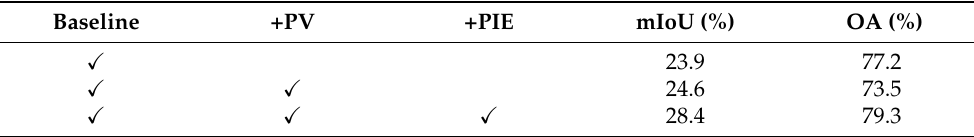
Table 4. The ablation research on the effectiveness of the prototype vector and the PIE module. We added the prototype vector and the PIE module sequentially to the baseline and observed the quality of the CAM on iSAID. +PV means the addition of the Prototype Vector, and +PIE means the addition of the PIE module. The mIoU (%) and OA (%) as the evaluation metrics for CAM quality are reported in the table.